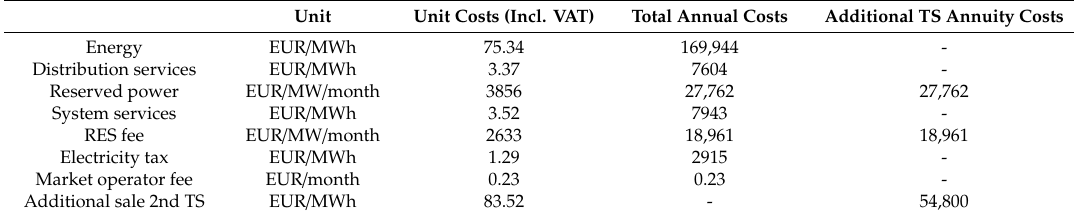
Table 2. Annual electricity bill [37,38].